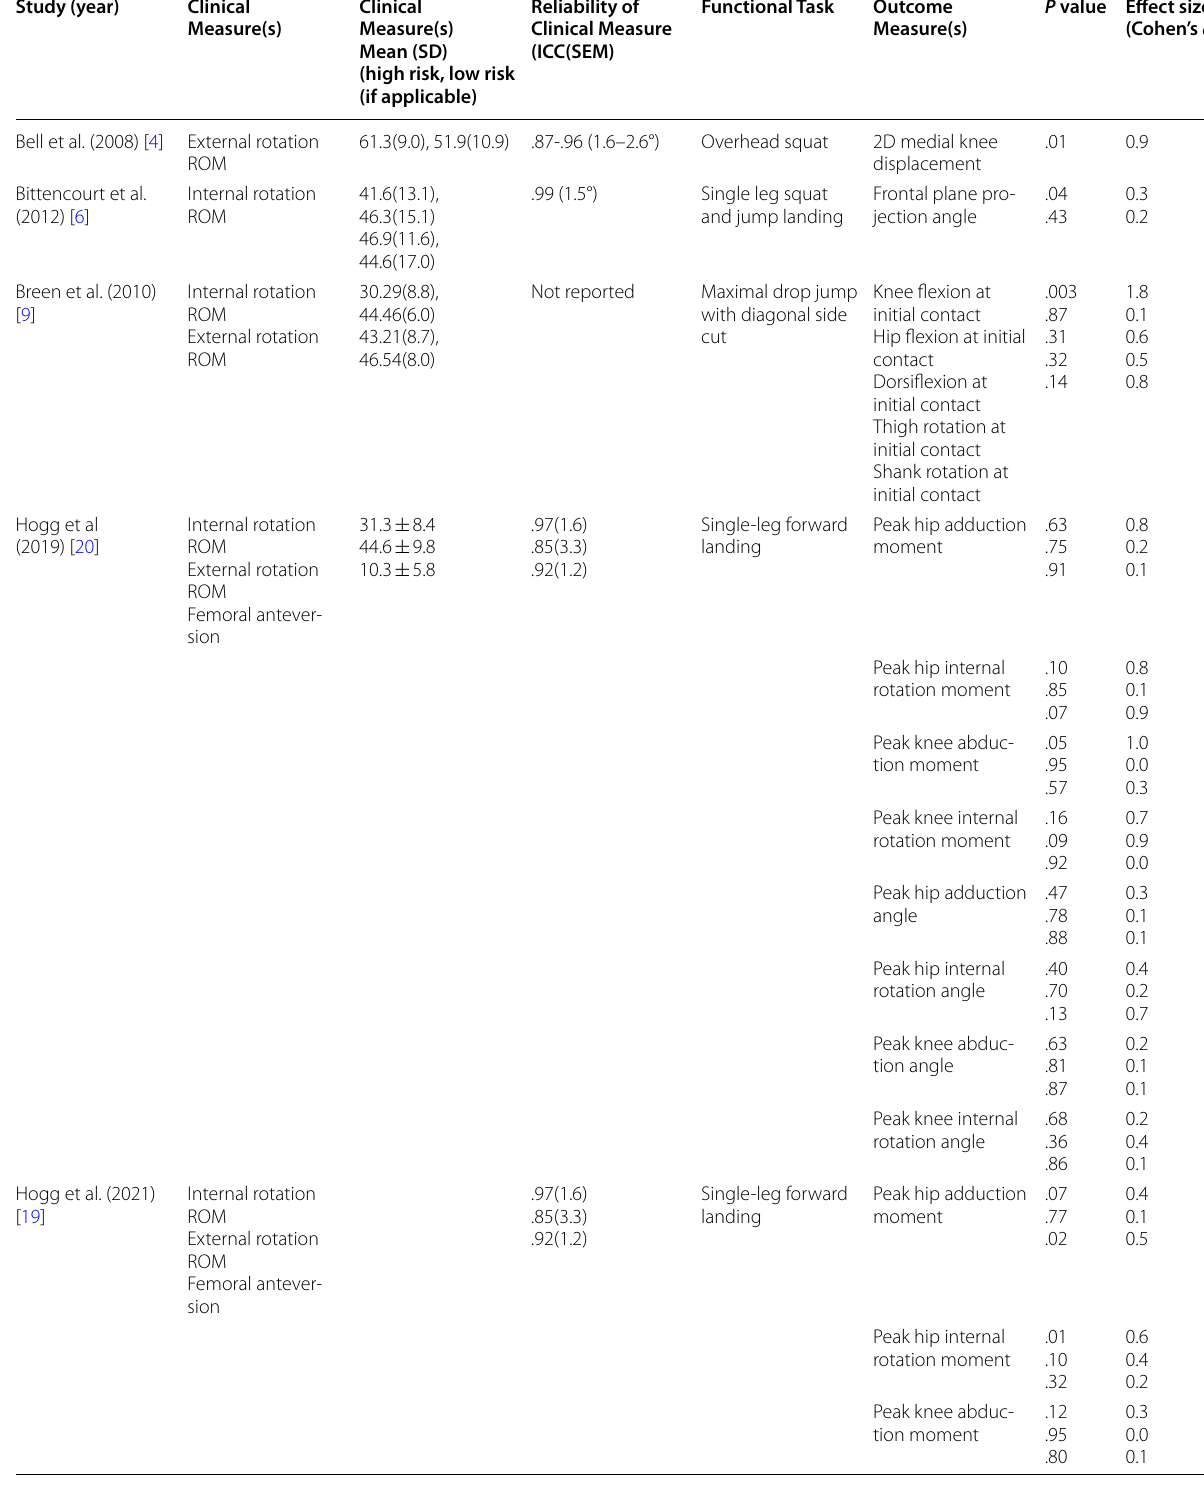
Table 6 Results of studies examining the relationship between transverse plane femoral alignment and biomechanics during a functional